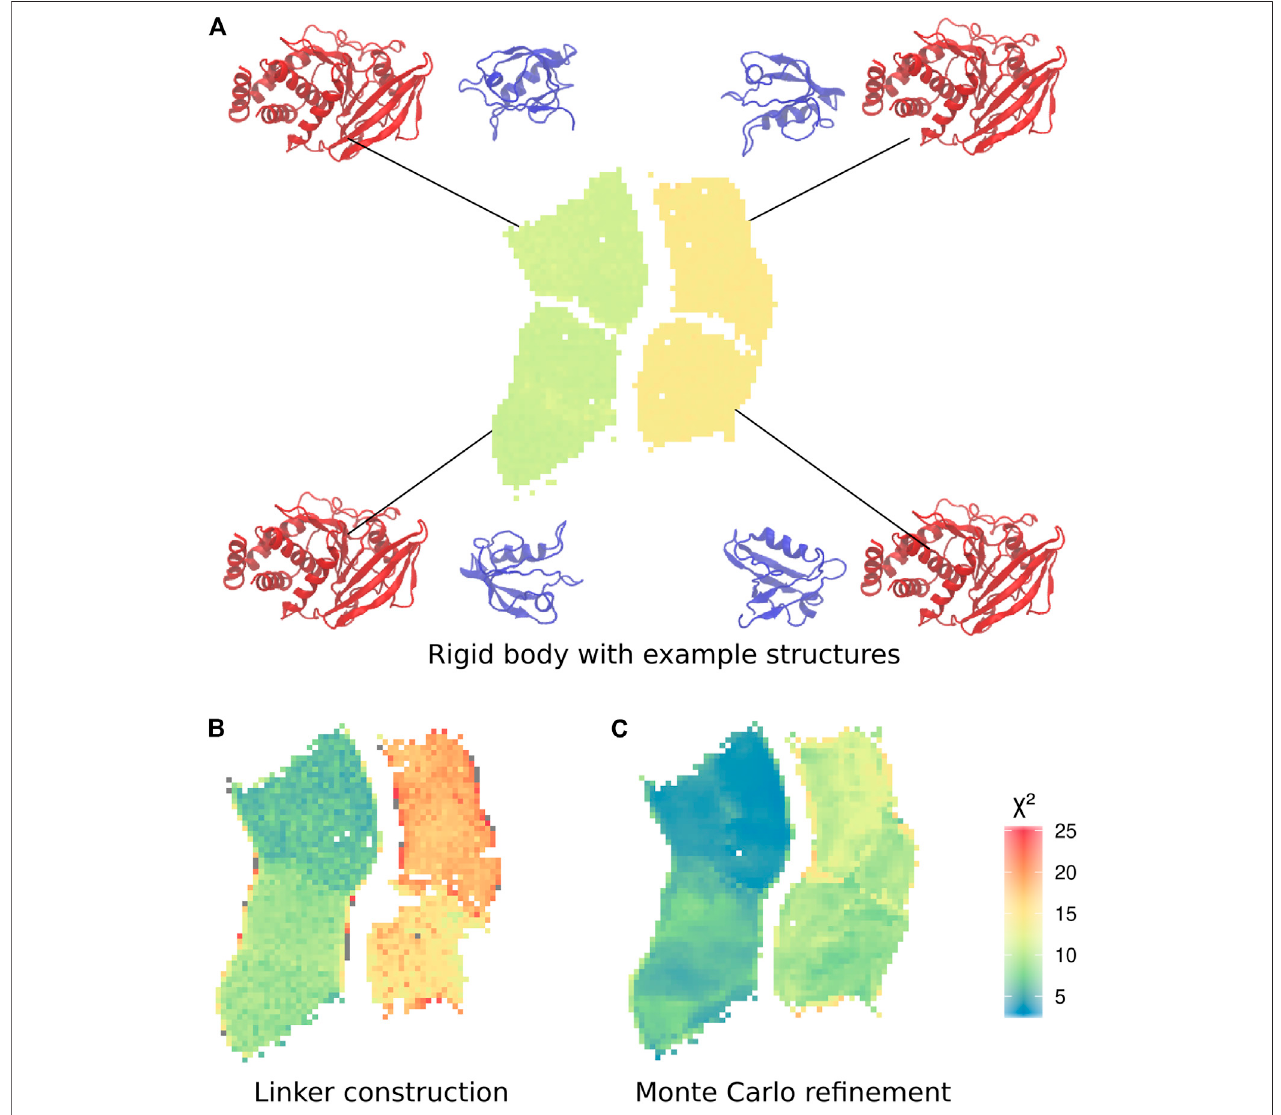
FIGURE 3 | Self-organizing maps (SOMs) of the three calculation stages. (A) Final conformations of the rigid body docking stage, coloured by χ 2 . Only SOM neurons with at least one structure are shown throughout. For each cluster, an example structure shows the relative orientation of the PDZ with respect to the phosphatase domain. (B) Best χ 2 for each docking pose with linker added. (C) Average χ 2 of minimized linker